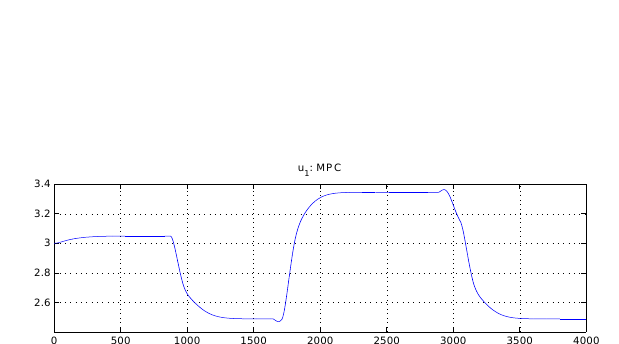
Figure 1: Simulation of the quadruple tank process and the minimum phase case in Example 6.1 with MPC control with integral action. Level ref- erences and actual levels illustrated. Predic- tion horizon L = 100 and control horizon L u = L .